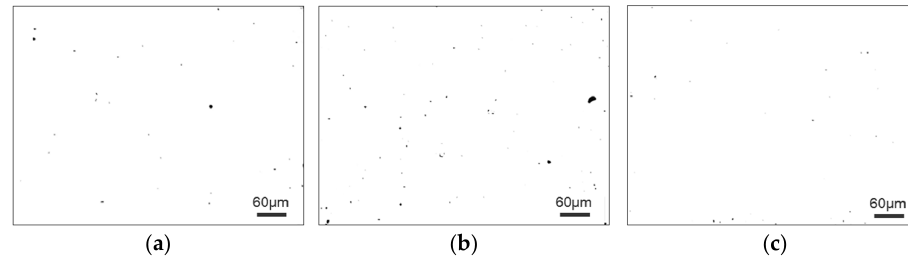
Figure 5. Inclusion distribution in DED samples: ( a ) P21; ( b ) STS316L; ( c ) FGM.